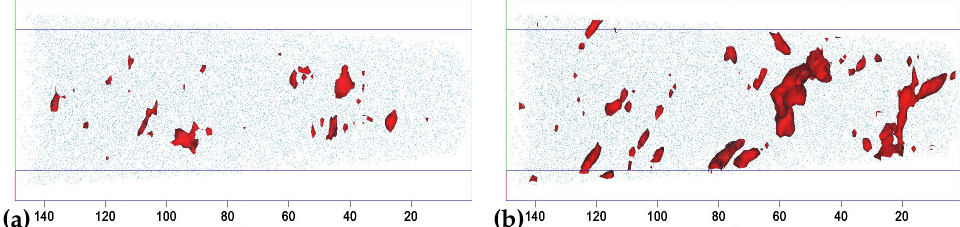
Figure A2. Carbon iso-concentration surfaces of tip C1 for the visualisation of volumes with carbon content ( a ) below 1.5at% and ( b ) above 6at% with Fe atoms added in blue to show the tip volume and length scales in